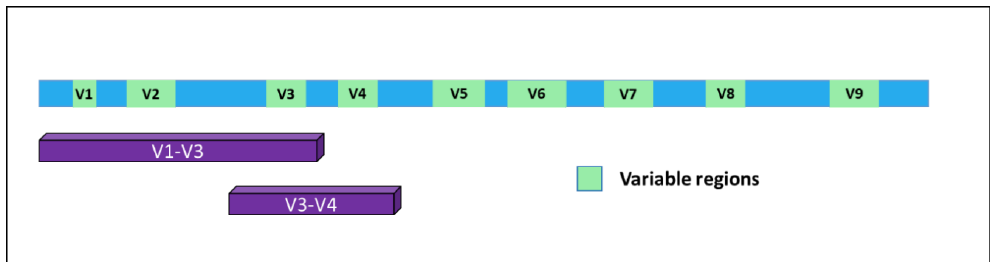
Figure 1. Structure of the 16S gene. The nine variable regions are depicted in green. Purple bars indicate the portions of the gene mostly used for bacterial classification upon PCR-based amplification and